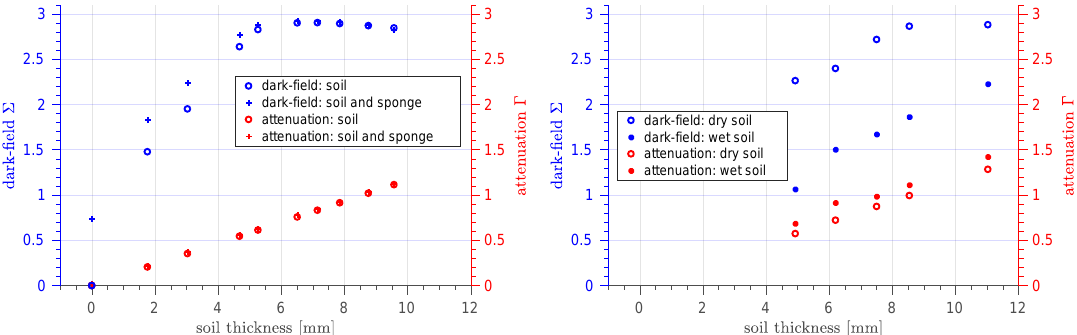
Figure 8. Attenuation (red) and dark-field values (blue) obtained by different heights of soil with two sponges (plus) and without (circle) are plotted over the thickness of soil ( left ). The first plus signs (soil thickness equal to zero) represent the dark-field and attenuation signal that the sponges generate. The effect on the attenuation (red) and dark-field values (blue) of dry soil (circle) and wet soil (filled circle) is compared for increasing heights of soil ( right